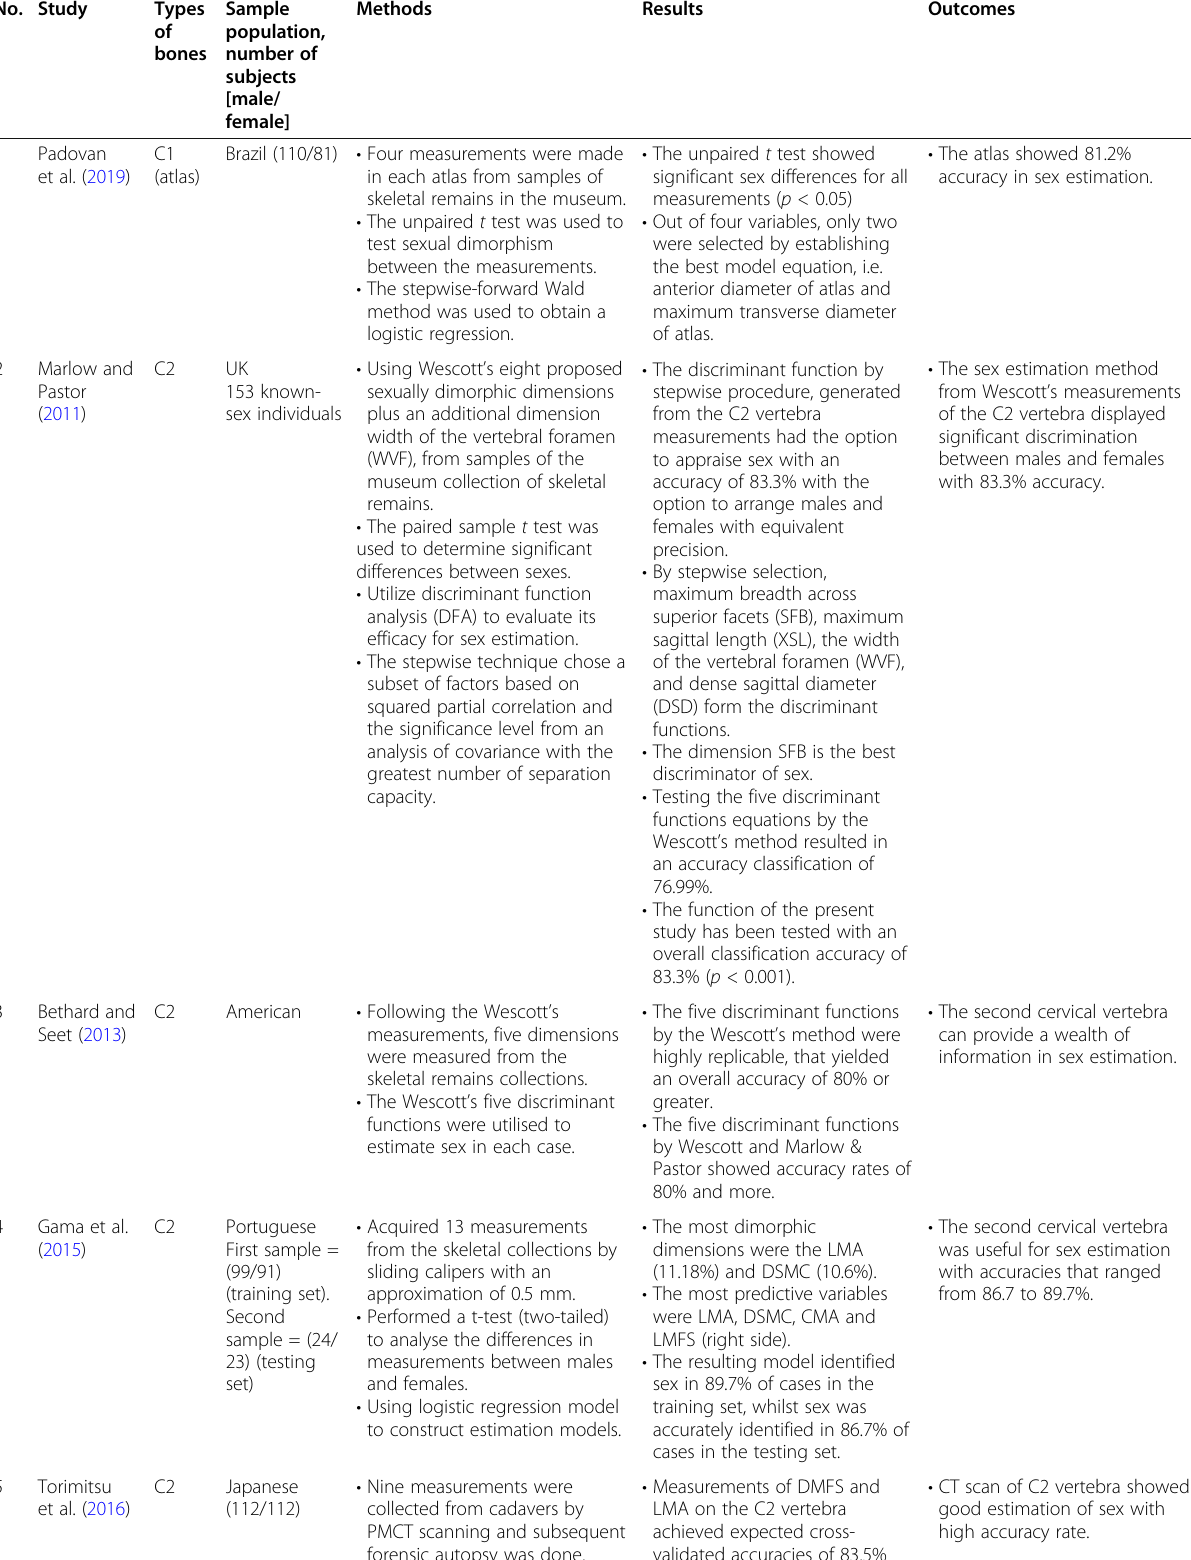
Table 1 The descriptive studies on sexual dimorphism in vertebral bone No.